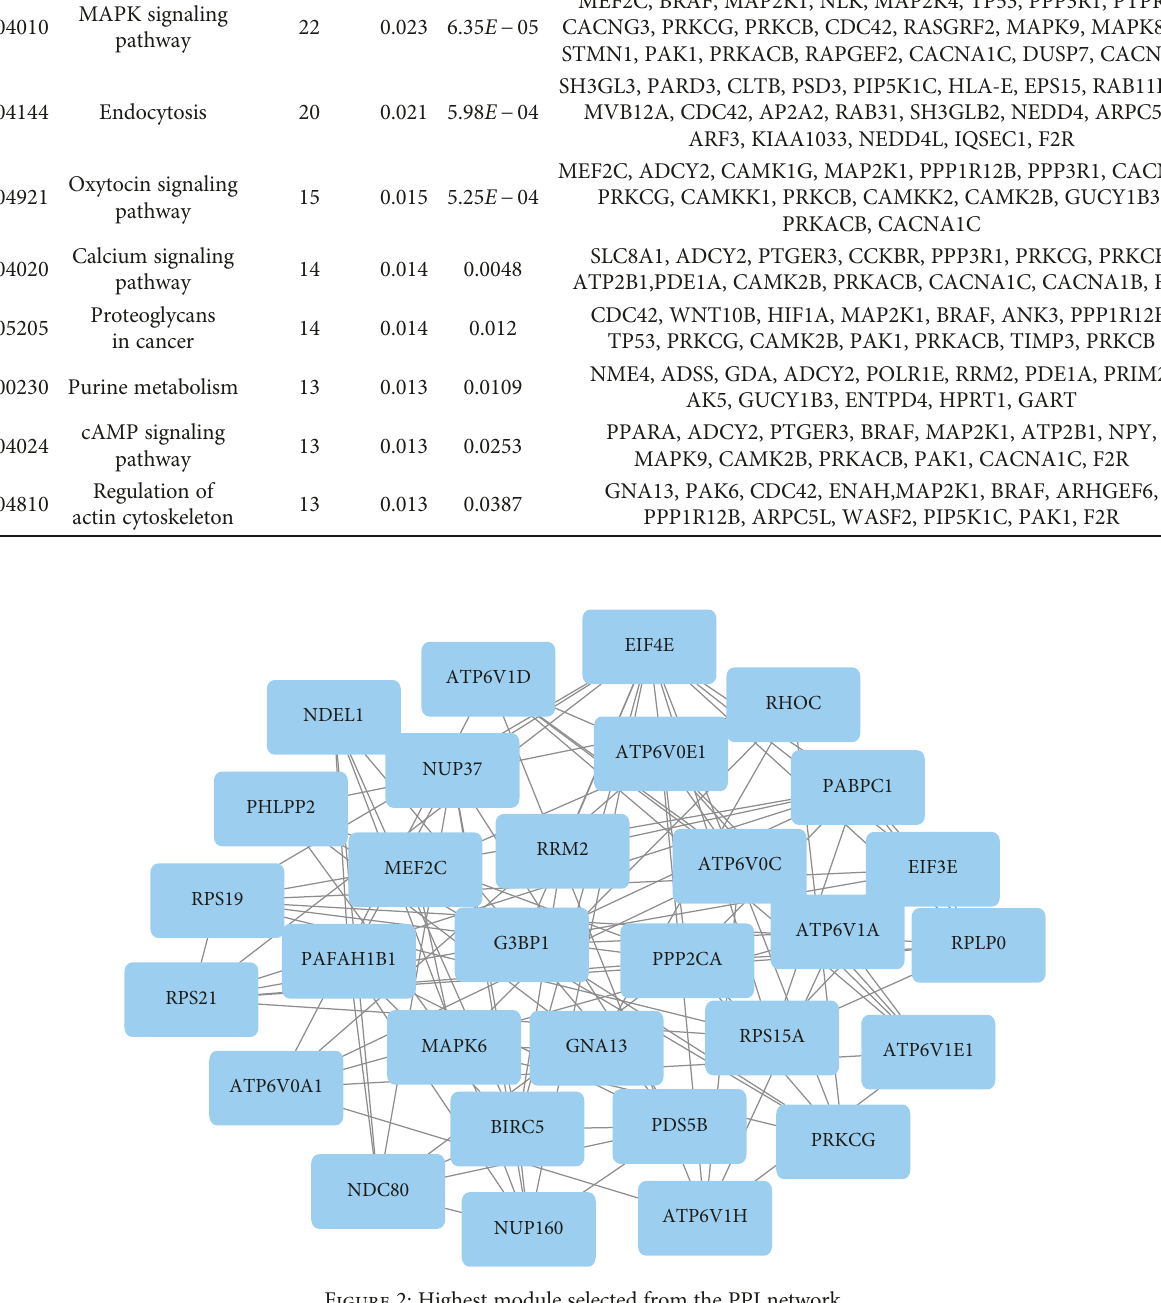
Figure 2: Highest module selected from the PPI